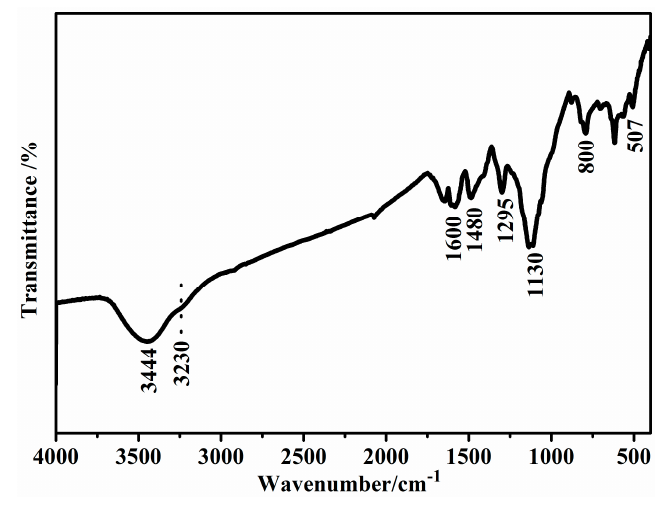
Figure 1. FTIR spectrum of the product prepared at CA/Ani = 0.5, APS/Ani = 1 with Ani of 2 mmol and ice bath for 24 h.